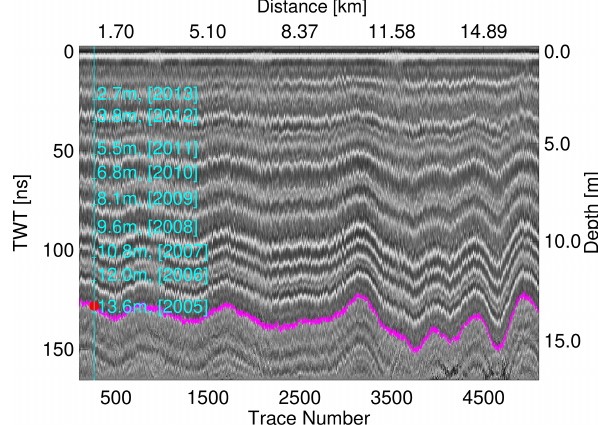
Figure 3. ASIRAS radargram at iSTAR site 21 with surface snow reflection centred at the origin of the TWT scale. The traced internal reflection layer is highlighted in magenta; annual markers from the NP profile at the point of closest approach are highlighted in cyan. The distance and trace numbers refer to the origin of the ASIRAS track segment 20156124 (see Table